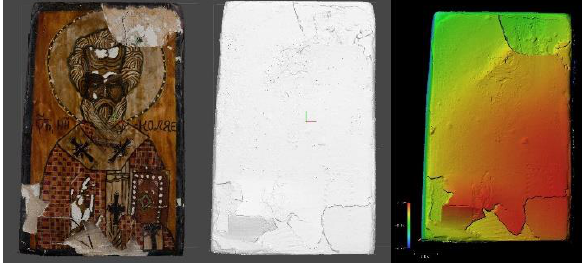
Figure 10. St. Nicholas., full body photogrammetry. Left: Textured 3D model. Center: Mesh. Right: DEM Similar deliverables with the first icon, were produced and